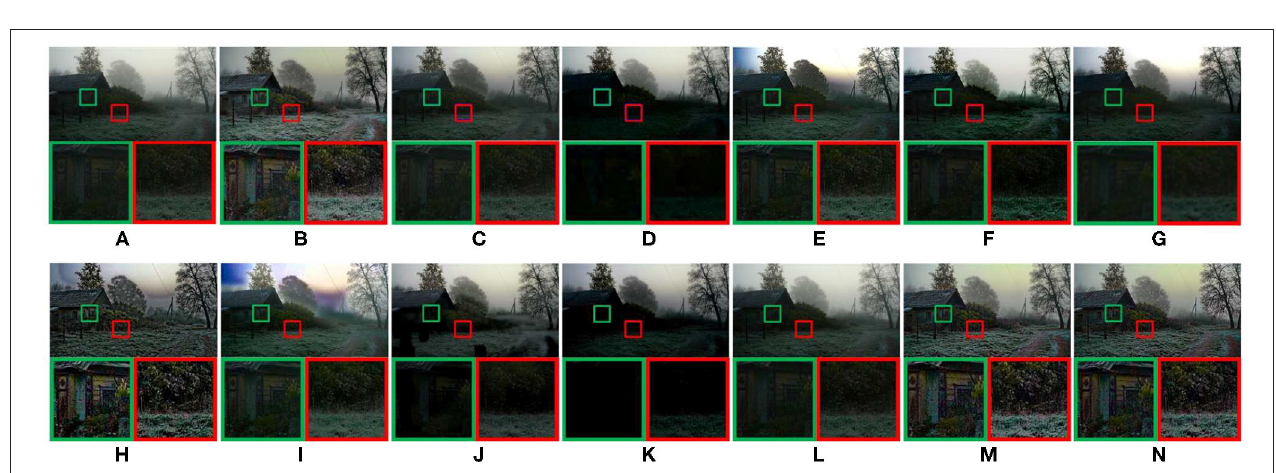
FIGURE 6 | Real-world rural natural image. (A) Represents the original foggy image. (B–N) Represent foggy-free images processed by AMEF, CAP, CO, DCP, DEFADE, GPR, MAMF, OTE, WCD, DehazeNet, FFA-Net, MIF, and the proposed